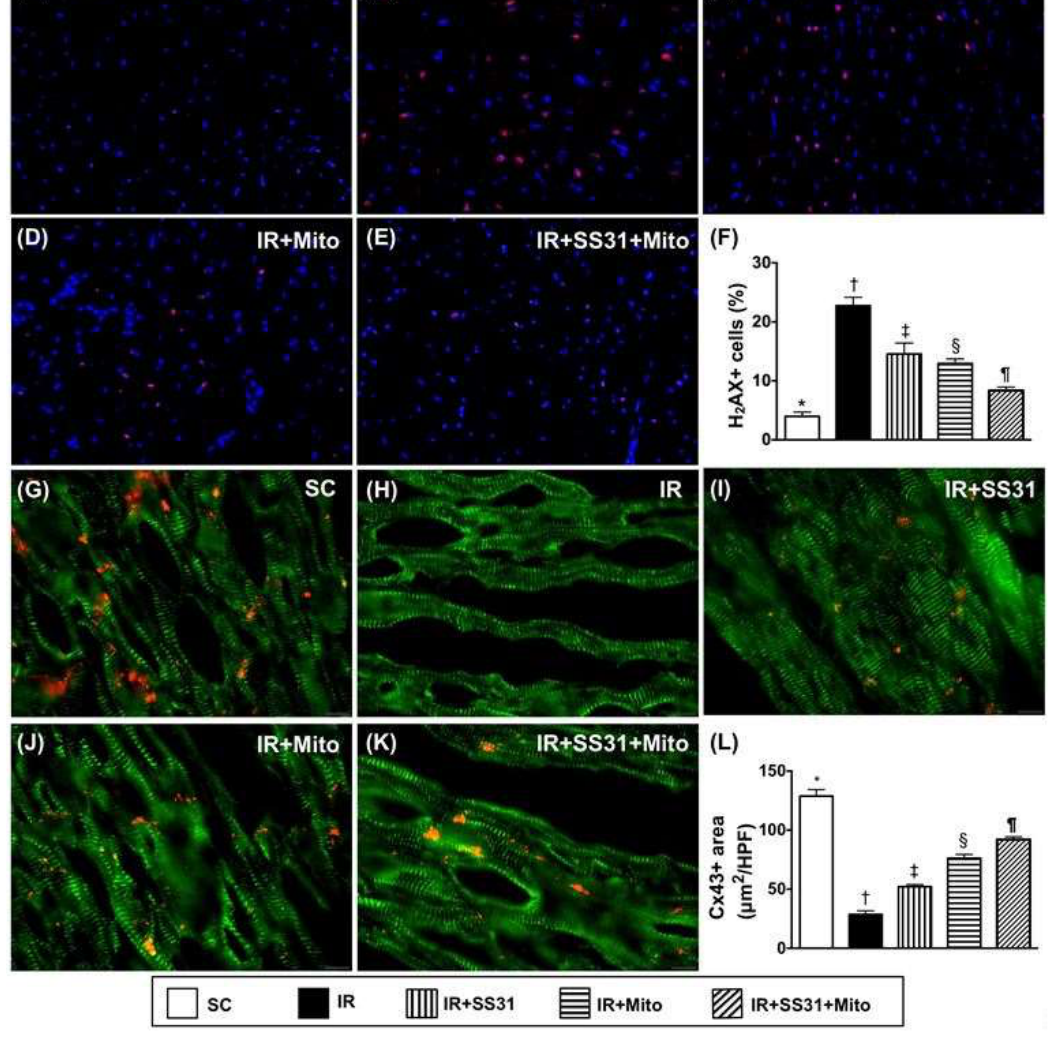
Figure 11. DNA-damage and Gap junction biomarkers in LV myocardium after the IR procedure. ( A – E ) Immunofluorescent (IF) microscopic finding (400×) of cellular expression of γ-H2AX (green). ( F ) Analytical result of number of γ-H2AX + cells * vs. other groups with different symbols (†, ‡, §, ¶), p < 0.0001. ( G – K ) IF microscopic finding (400×) of cellular expression of connexin43 (Cx43). ( L ) Analytical result of positively-stained Cx43 * vs. other groups with different symbols (†, ‡, §, ¶), p < 0.0001. Scale bars in the right lower corner represent 20 μm. All statistical analyses were performed by one-way ANOVA, which was followed by the Bonferroni multiple comparison post hoc test ( n = 8 for each group). Symbols (*, †, ‡, §, ¶) indicate significance at the 0.05 level. SC = sham control. IR = ischemia-reperfusion. Mito = mitochondria.